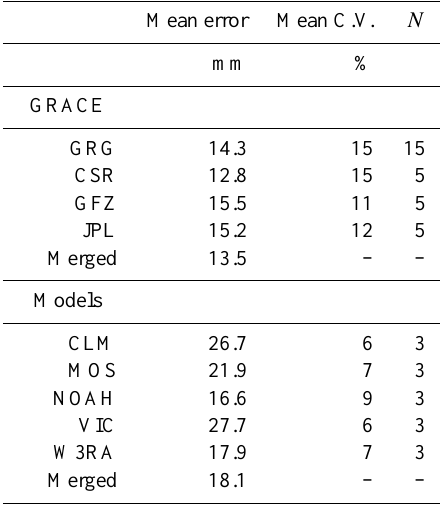
Table 2. Spatial mean values (non-glaciated land areas only) of the error in monthly mass change estimates for different GRACE and model sources as derived through triple collocation. Also listed is the number of triple collocation estimates derived ( N ) and the spa- tial mean of the coefficient of variation (C.V.) in these N estimates.